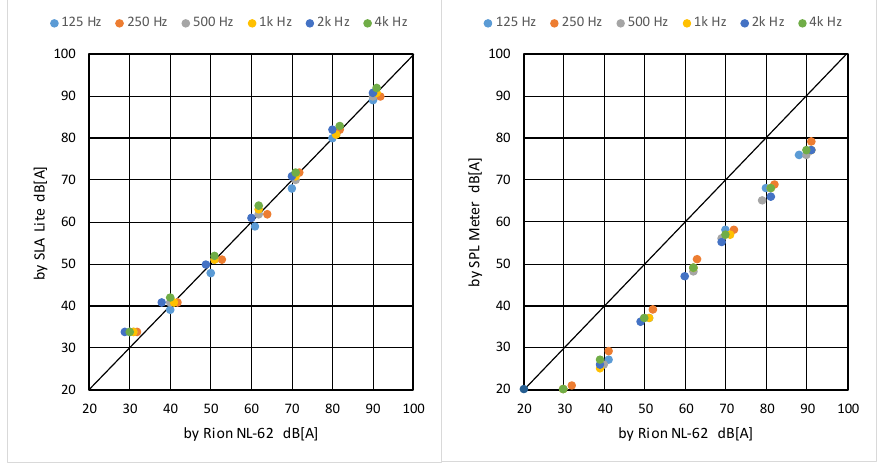
Figure 7. Results of accuracy test of SPL (A-weighted) by measuring applications on iPad Pro (9.7” display, model MLQ421A, released March 2016). SLA Lite (left) and SPL Meter (right) compared with a class 1 SLM.